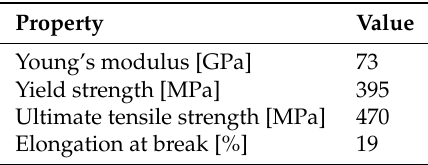
Table 6. Actual mechanical properties of the Al 2024-T4